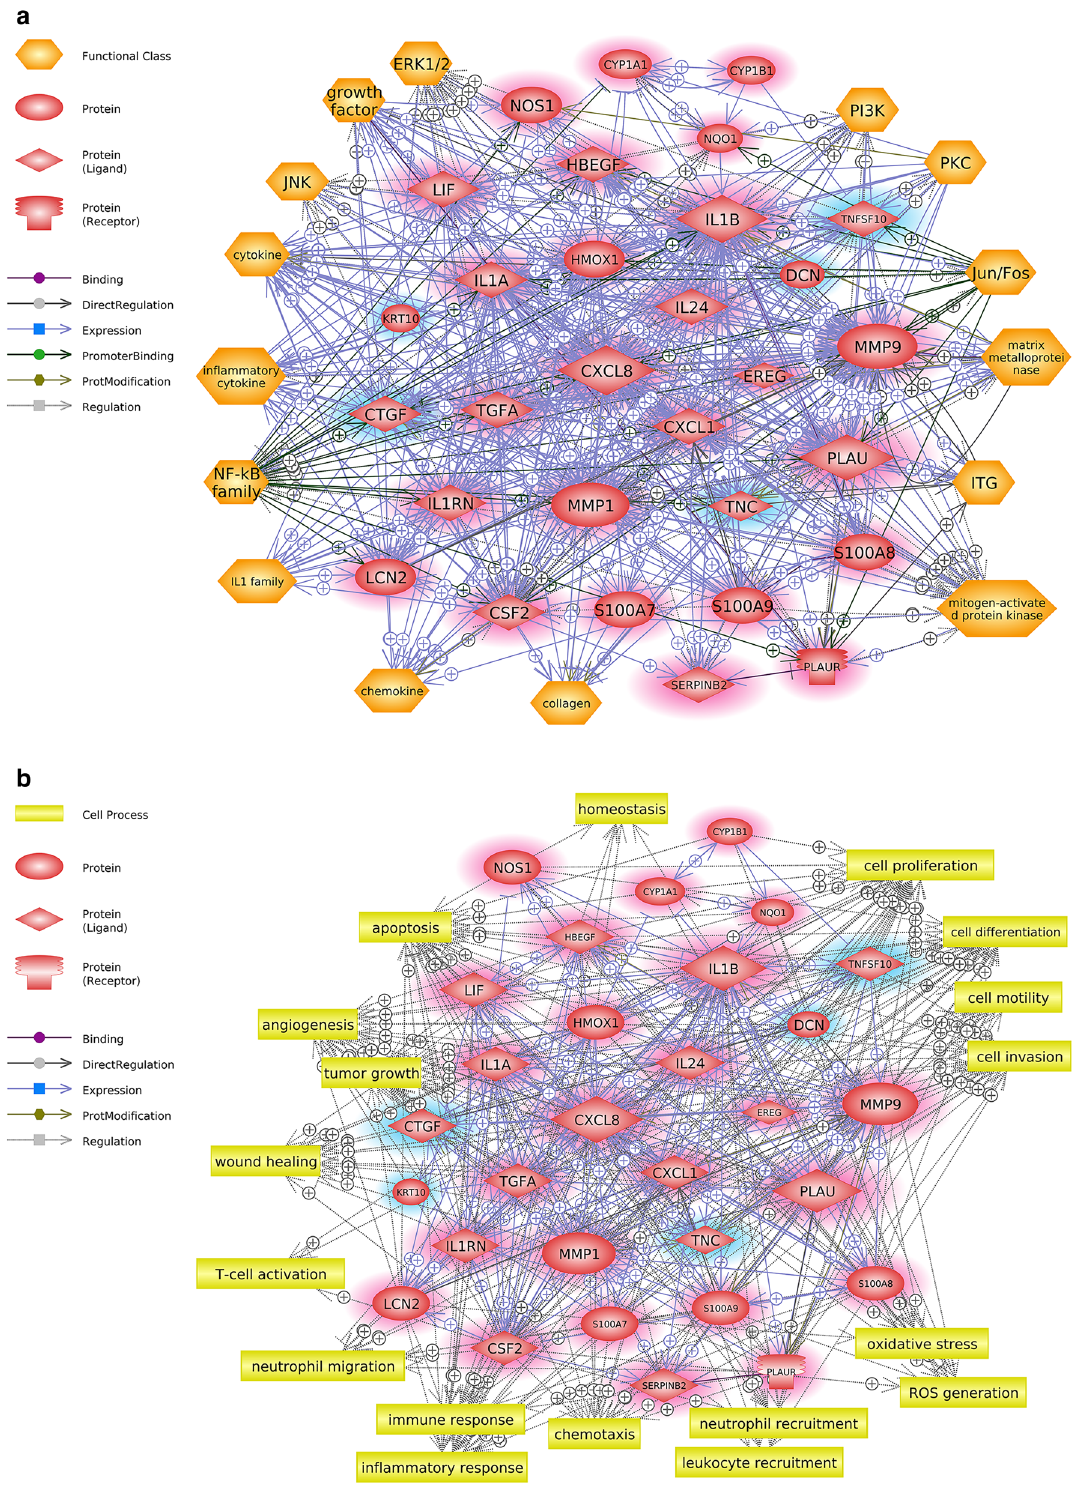
Figure 3. Potential biological signaling networks related to PM-induced skin diseases predicted from our NGS-based experimental data. Direct biological interaction among the identified DEG from in vitro RNA-seq analysis. ( a ) Biological functions predicted to be altered according to the signaling networks were analyzed using Pathway Studio. The predicted functions are presented as a “functional class” among the genes in the pathway. ( b ) Cellular processes predicted to be affected according to the signaling networks were analyzed using Pathway Studio. The descriptions of the schematic symbols are located to the left of each figure. Upregulated and down regulated genes are highlighted in pink and blue